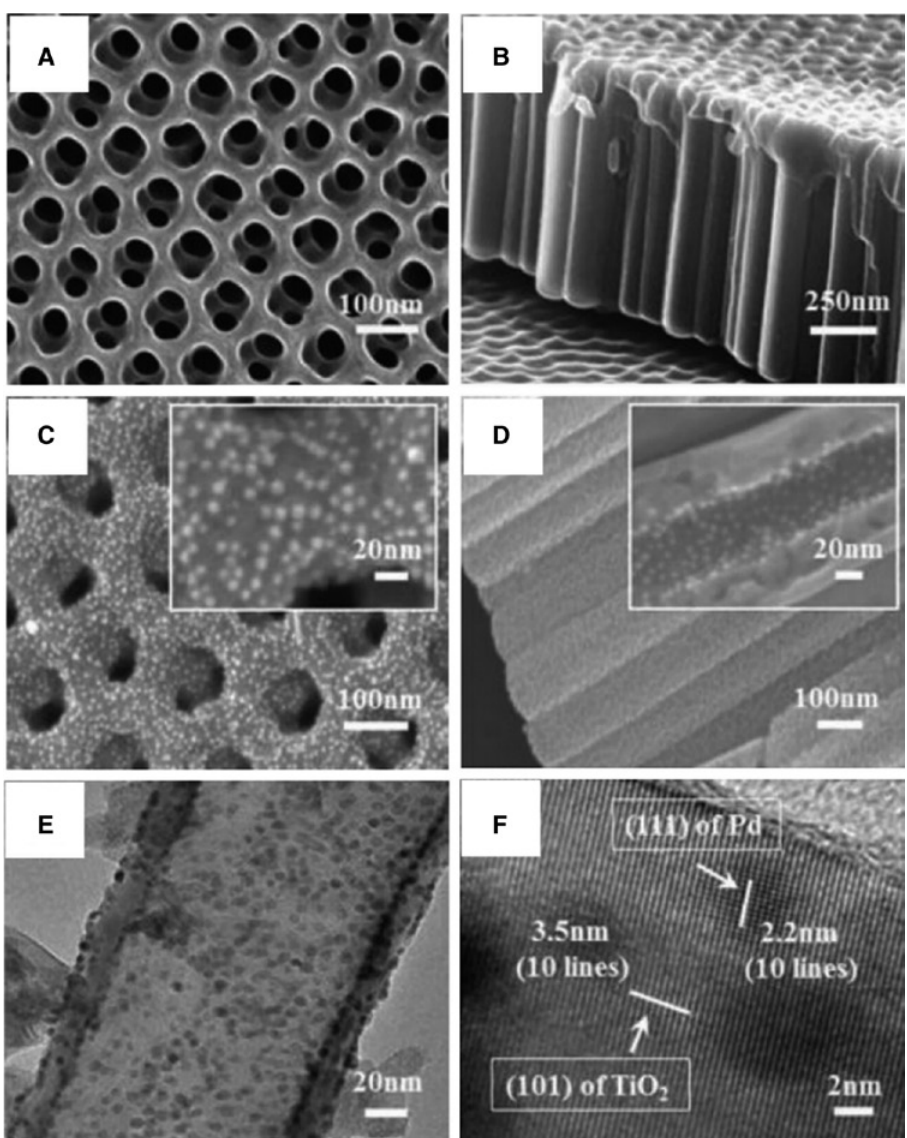
NTAs (C), (D). The insets show the corresponding 2 NTAs coated with Pd QDs. Reproduced from Ref. [154] with permission. Copyright 2